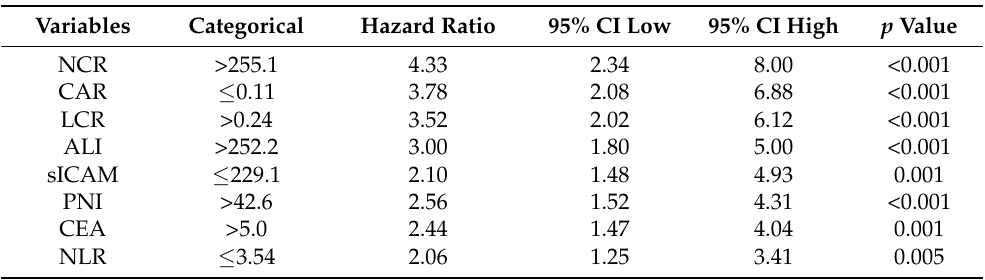
Figure 2. Clinical significance of the preoperative NCR in patients with colon cancer from the discovery cohort according to ( a ) the UICC classification: NCR levels were significantly decreased in a staged dependent manner; and ( b ) sidedness: significantly decreased NCR levels were observed in patients with right-sided colonic cancer. Table 5. Hazard Ratios for various predictive parameters (Cox regression analysis of the OS of patients with colon cancer in the discovery cohort).